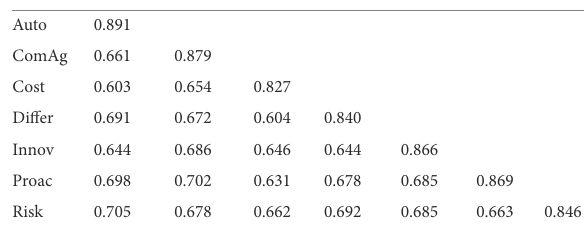
TABLE 2 Measurement model.